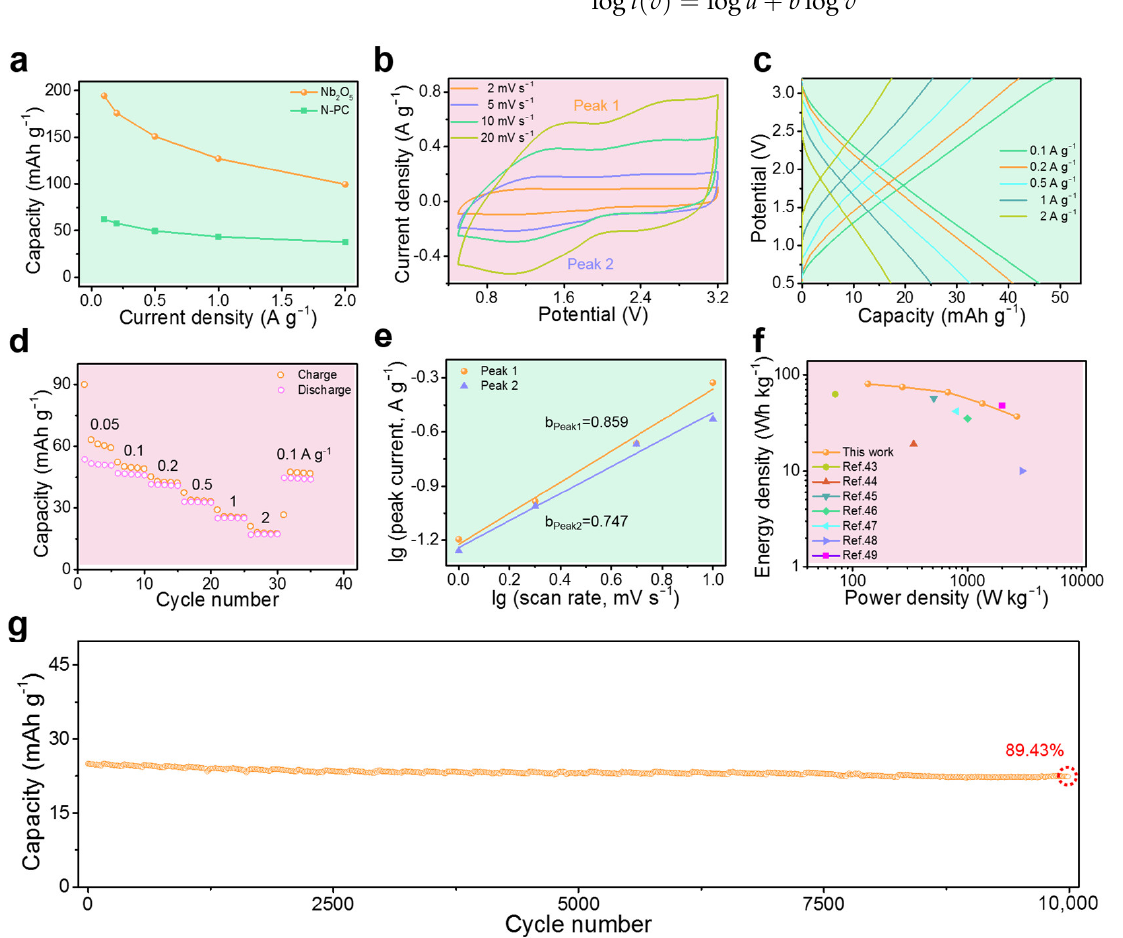
Figure 6. Electrochemical properties of the high-performance lithium-ion capacitor. ( a ) Capacity at different current densities for the N−PC cathode and T−Nb 2 O 5 anode. ( b ) CV curves at different scan rates. ( c ) GCD curves at different current densities. ( d ) Rate performance of the lithium-ion capacitor. ( e ) Calculation curve of b-values at different scan rates of 1−10 mV s −1 . ( f ) Ragone plots of the high-performance lithium-ion capacitor and others reported in the literature. ( g ) Cycling stability of the lithium-ion capacitor.